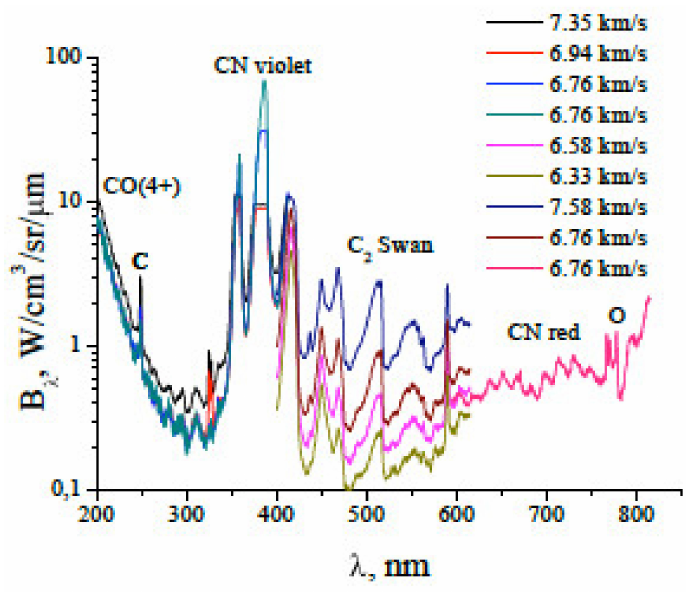
Figure 47. Spectral power densities for a pressure of 0.3 Torr (from